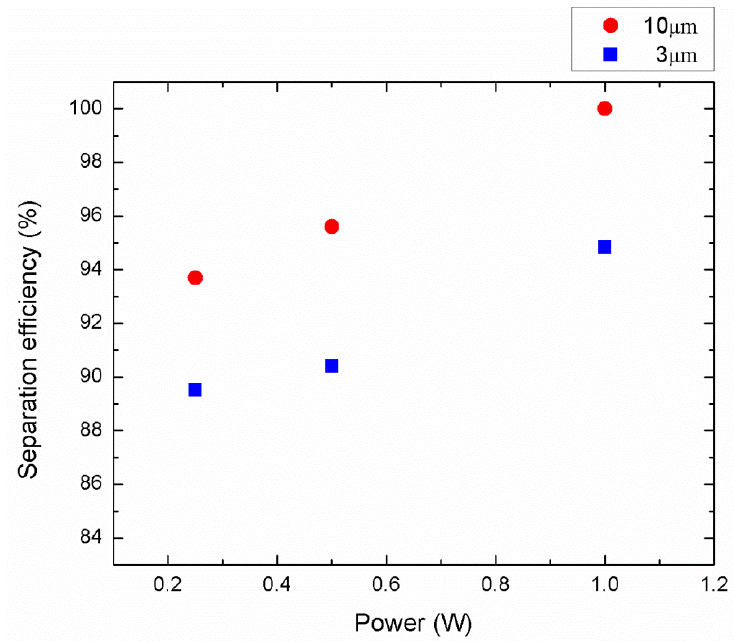
Figure 10. Separation efficiency as a function of input power for 3 and 10 μ m particles (driving frequency: 13.2 MHz, flow rate: 0.5 μ L/min, particle concentration: 1% by